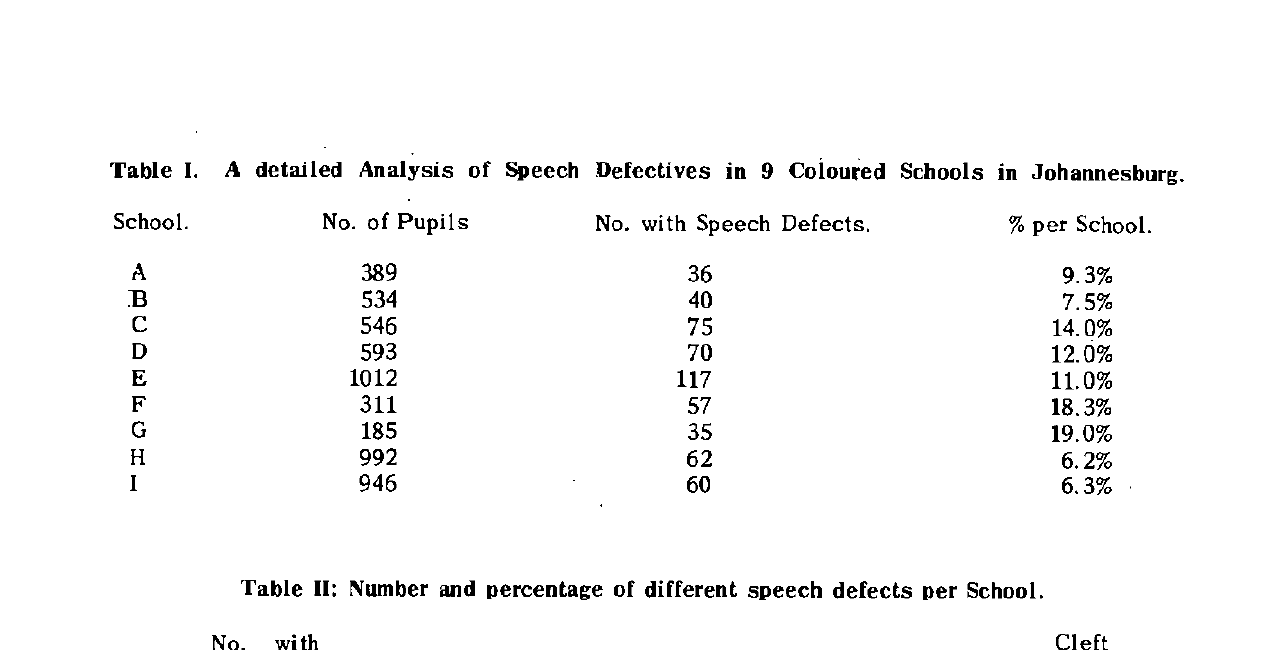
Table II: Number and percentage of different speech defects per School.